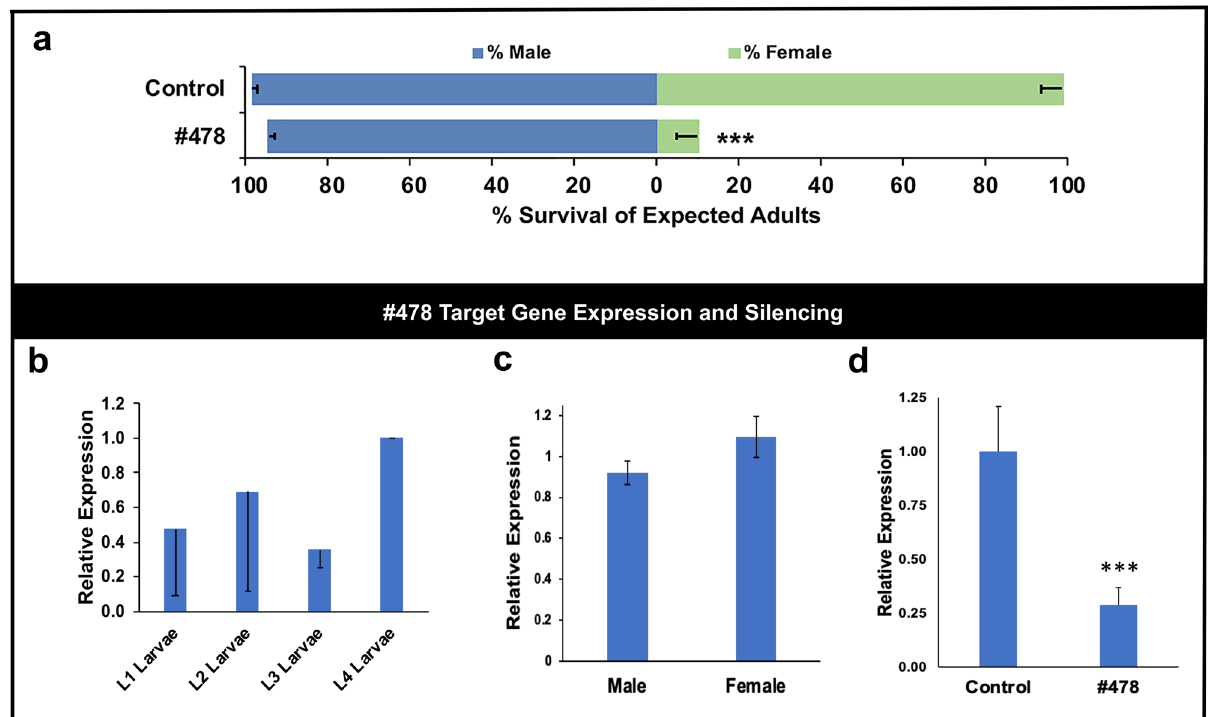
Figure 2. A female-specific lethal yeast interfering RNA larvicide targeting lncRNA genes. Significant female larval mortality resulted from oral consumption of yeast interfering RNA larvicide strain #478 [( a ), *** = p < 0.001, Chi-square]. No significant death was observed in males following treatments with larvicide [( a ); p > 0.05, Chi-square], and a control interfering RNA strain did not significantly impact survival of male or female larvae [( a ) p > 0.05, Chi-square; data are represented as mean survival based on adult emergence following treatment of 180 total larvae, and error bars denote SEM]. ( b – d ) display quantification of the identical AAEL020379, AAEL020813, and AAEL022952 transcripts, with mRNA levels normalized to levels of the rpS17 housekeeping gene; error bars denote standard deviations. The #478 larvicide target transcripts are expressed throughout larval development in untreated first (L1), second (L2), third (L3), and fourth (L4) instar larvae ( b ), with no significant differences in expression levels noted between the various larval stages ( p > 0.05, ANOVA; the expression levels are shown relative to L4). No significant differences in transcript levels were noted between third instar male and female larvae [( c ), t-test, p > 0.05]. Silencing of these lncRNA targets of larvicide #478 ( d ) was confirmed through qRT-PCR (*** = p < 0.001 vs. target gene levels in control interfering RNA-fed larvae, Student’s t-test; error bars denote standard